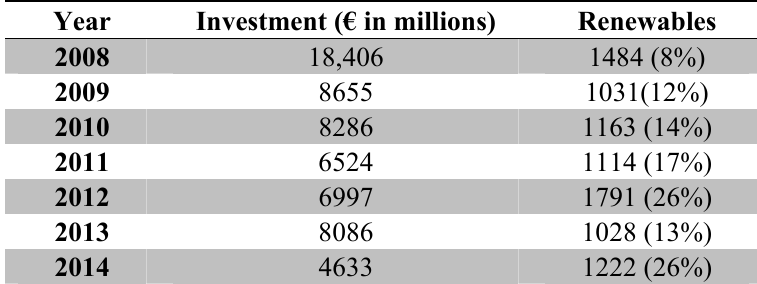
Table 5. E.ON–overall investment and share of investment in renewables